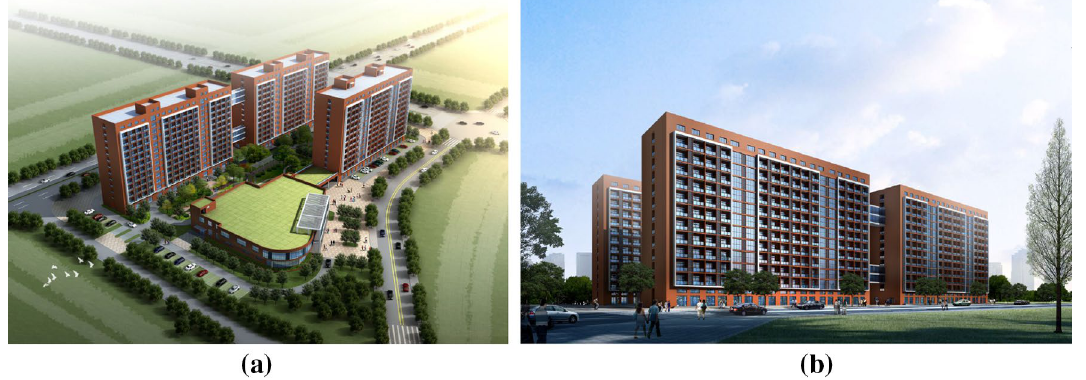
Figure 2. Architectural renderings of prefabricated apartment for talented